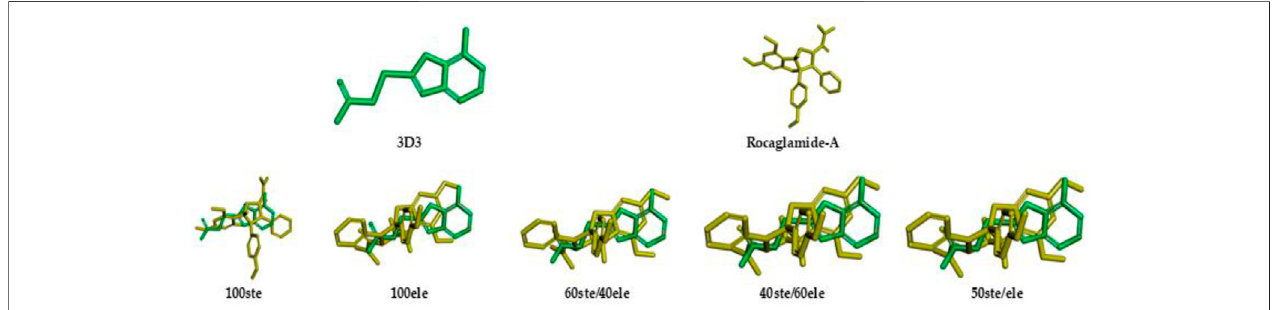
FIGURE 5 | Representations of overlap similarities between molecular structures of 3D3 ligand (green) and Rocaglamide-A (yellow) according to different steric/ electrostatic contributions.